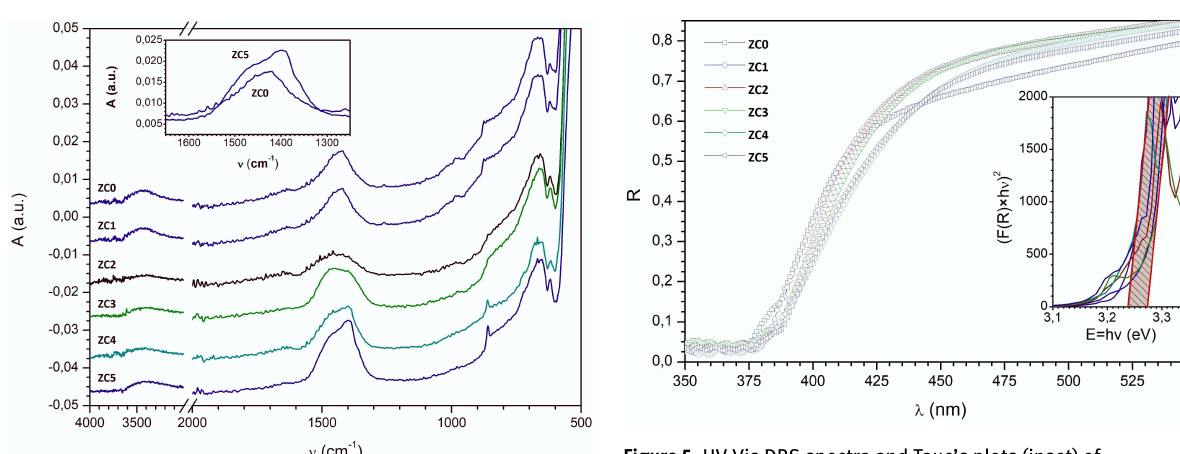
Figure 5: UV-Vis DRS spectra and Tauc’s plots (inset) of mechanochemically prepared samples with various shares of